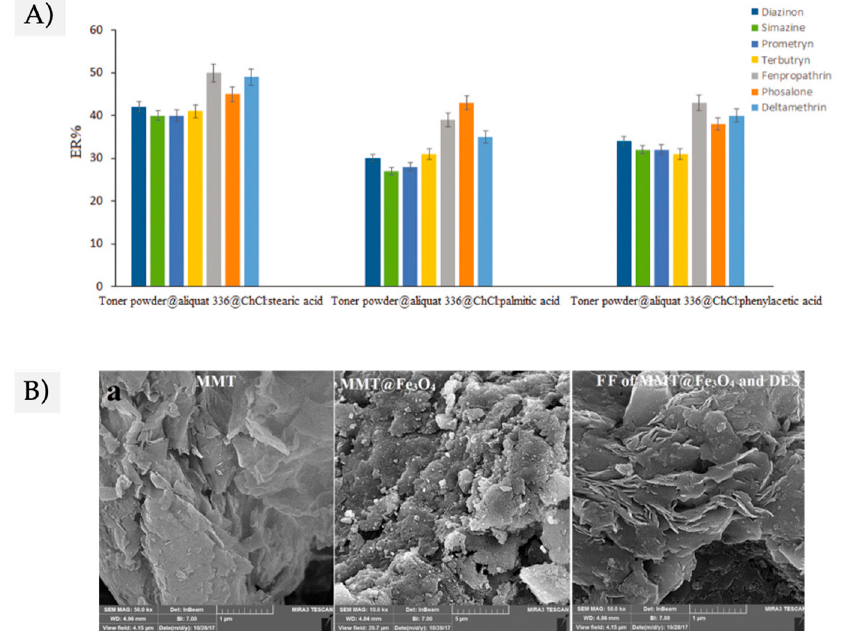
Figure 4. ( A ) Study of the effect of the hydrogen bond donor (HBD) (selected to prepare the deep eutectic solvents (DES)) on the extraction efficiency of the DES-FF for 7 pesticides. Figure adapted from [38] with permission from Taylor & Francis Group ( B ) SEM images of neat clay (montmorillonite, labeled as MMT), the clay@Fe 3 O 4 and the clay@Fe 3 O 4 : DES, as an example of magnetic nanocomposites rather than other conventional MNPs in FFs. Figure adapted from [44] with permission from Elsevier.